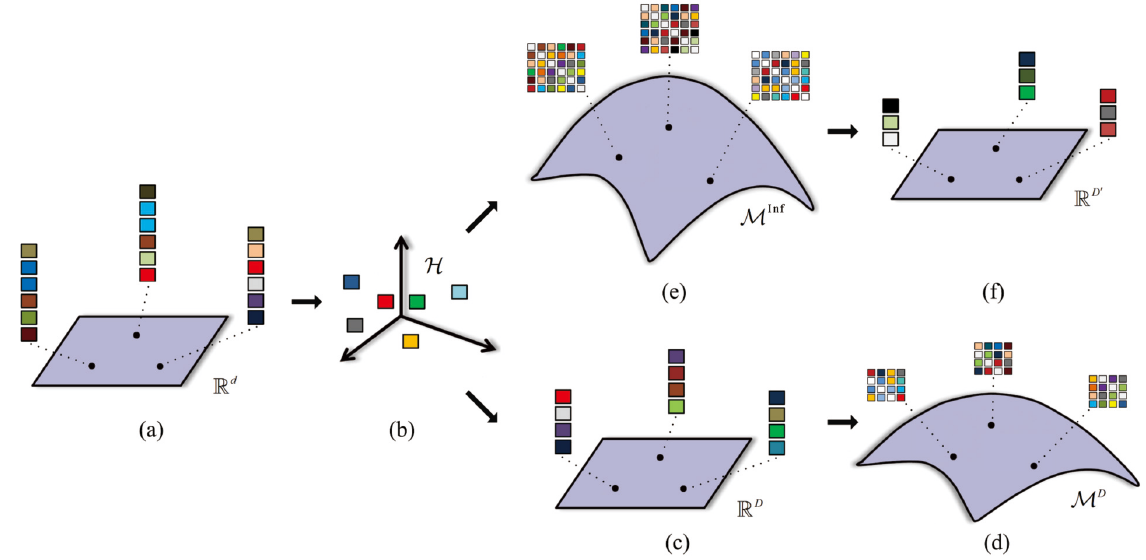
Fig. 1 Conceptual comparison of our approach and Faraki et al.’s approach for image classification. Faraki et al.’s approach follows (a)– (d), (a) first mapping image features in low-dimensional Euclidean space to an infinite-dimensional Hilbert space (b) and then applying the Nystr¨om method to learn a feature mapping from Hilbert space to another low-dimensional Euclidean space (c), which can be used to obtain the finite-dimensional approximations of infinite-dimensional CovDs (d). In contrast, the proposed approach follows the path (a)–(b)–(e)–(f) to learn a feature mapping from the Riemannian manifold of infinite-dimensional CovDs (e) to a new low-dimensional Euclidean space (f) to obtain the vectorial